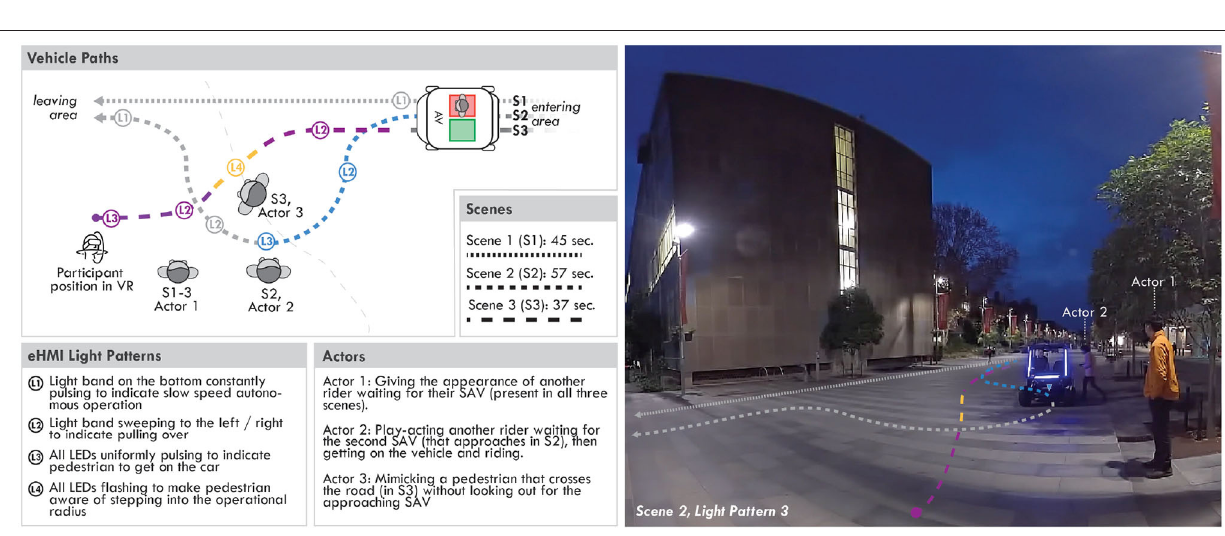
FIGURE 4 | Recording plan of the three scenes, vehicle trajectories and eHMI light patterns (left) ; screenshot taken from the 360-degree video prototype representing the second scene with an actor entering the SAV (right)